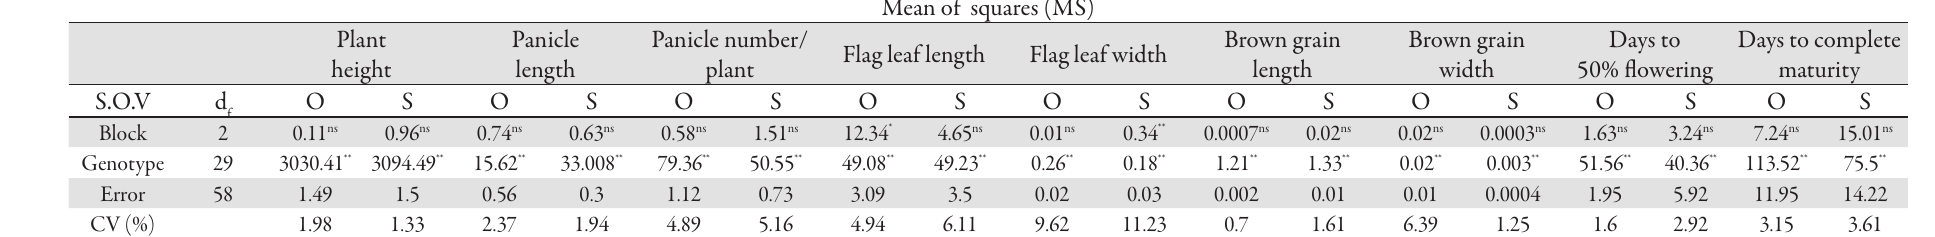
Tab. 1. Analysis of variance of studied traits in 30 rice cultivars under two irrigation regimes optimum irrigation (O) and drought stress(S)